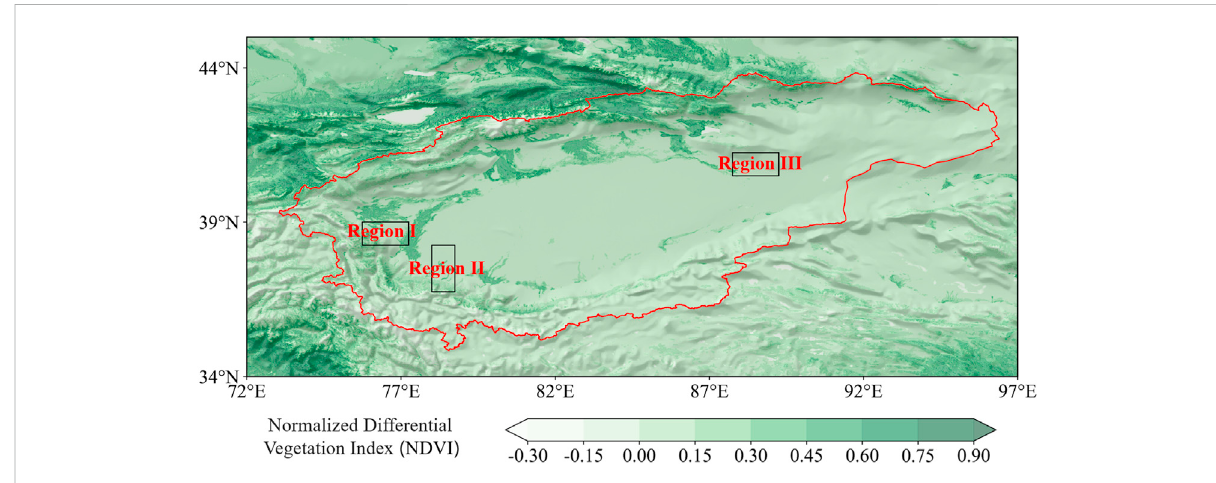
FIGURE 5 Supposed irrigation regions with two grid cells for scenario comparison in the Tarim Basin with growing season normalized differential vegetation index (1980 – 2018 mean) and terrain.